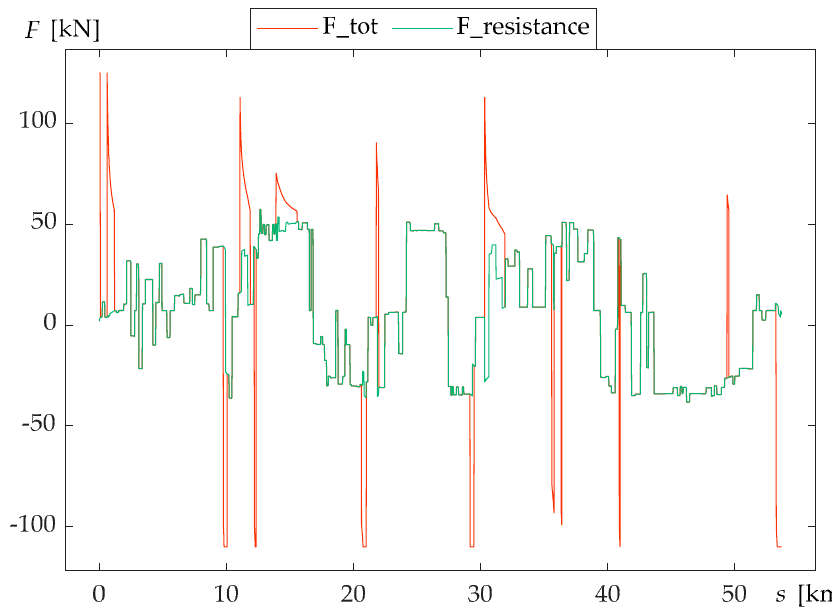
Figure 5. Demand force and the resistance force of the railway.